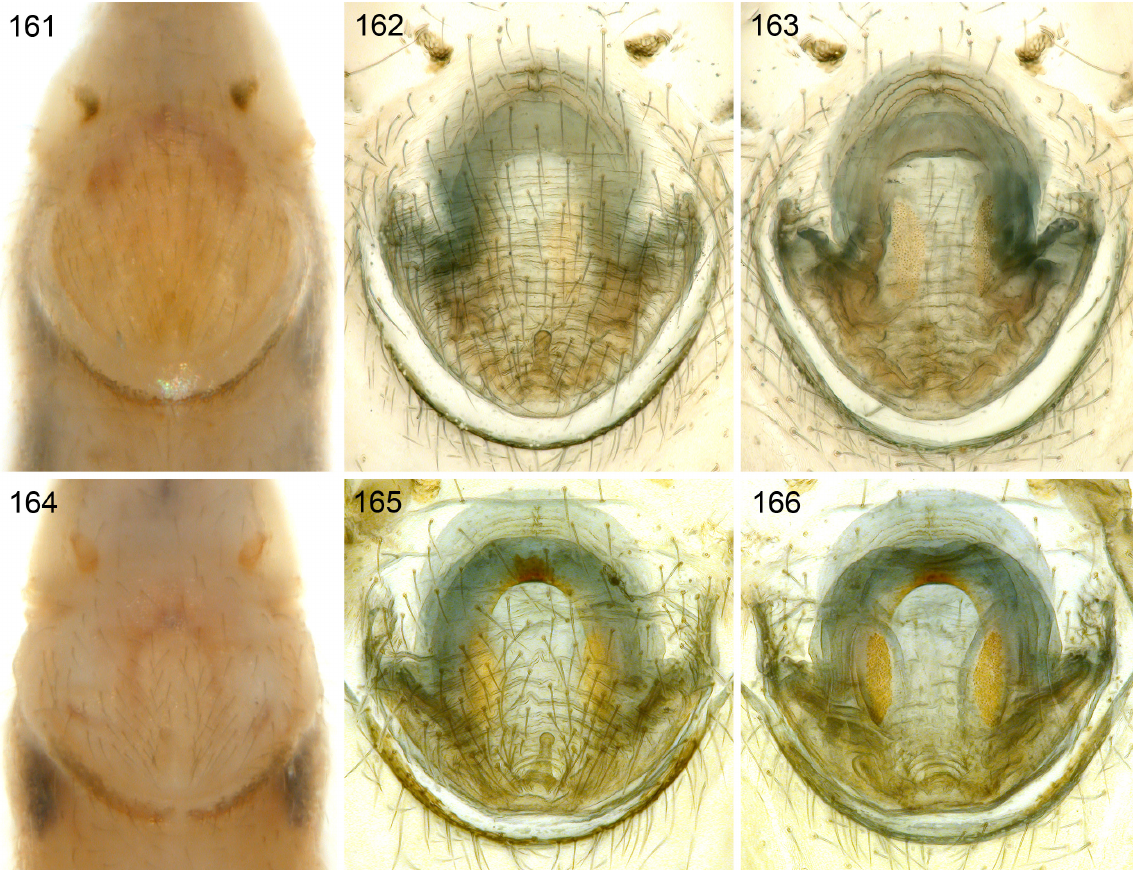
Figs 161–166. epigyna, ventral views, and cleared female genitalia, ventral and dorsal views. 161–163 . Pholcus domingo Huber sp. nov. (ZFMK, Ar 15721). 164–166 . P. matutum Huber sp. nov. (ZFMK, Ar